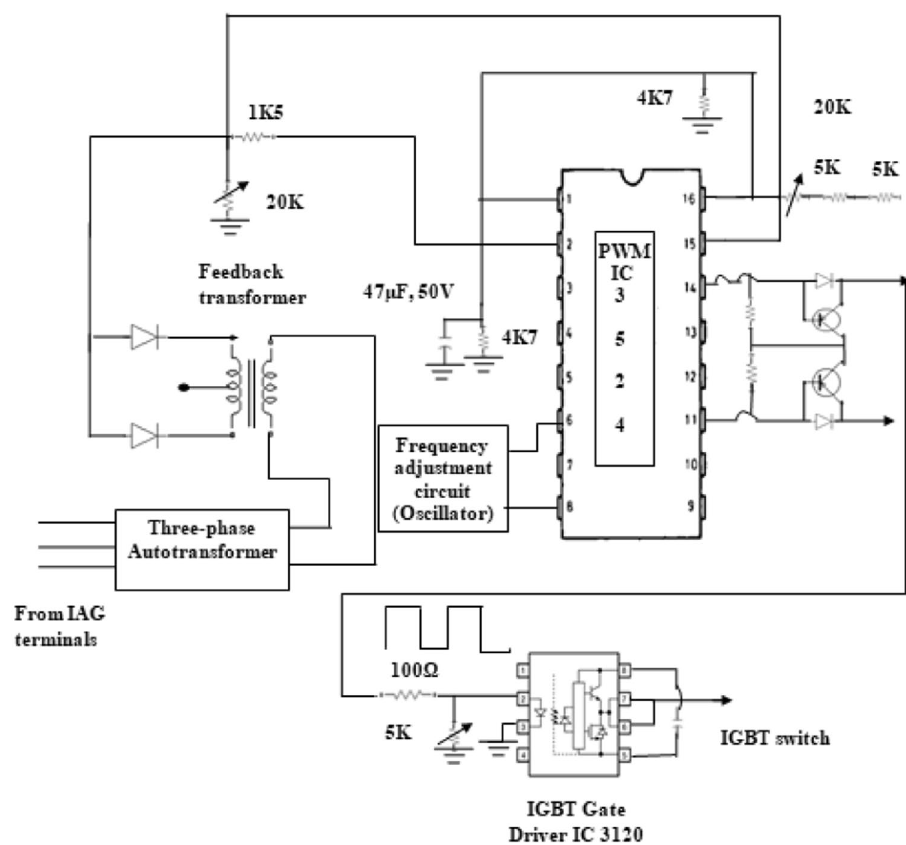
Fig. 2 Hardware diagram of the control